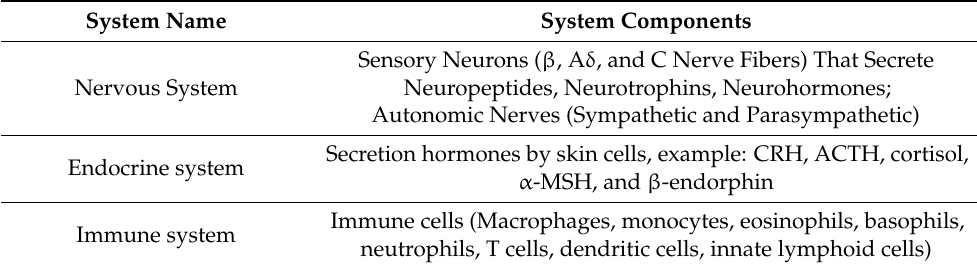
Table 1. Components of the nervous–endocrine–immune network in the